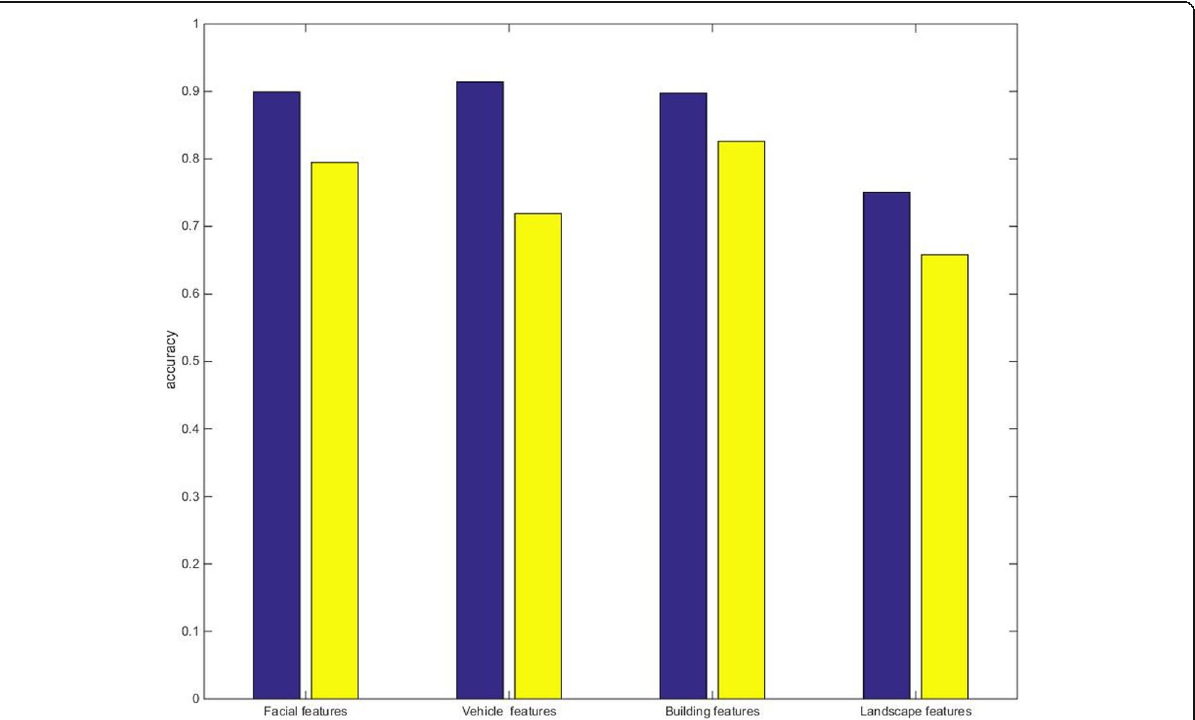
Fig. 7 Recognition results of low frequency and high frequency. Recognition results of low frequency and high frequency (the x-coordinates are four kinds of images, which are facial features, vehicle features, building features, and landscape features. The two histograms of each feature correspond to low frequency and high frequency features,